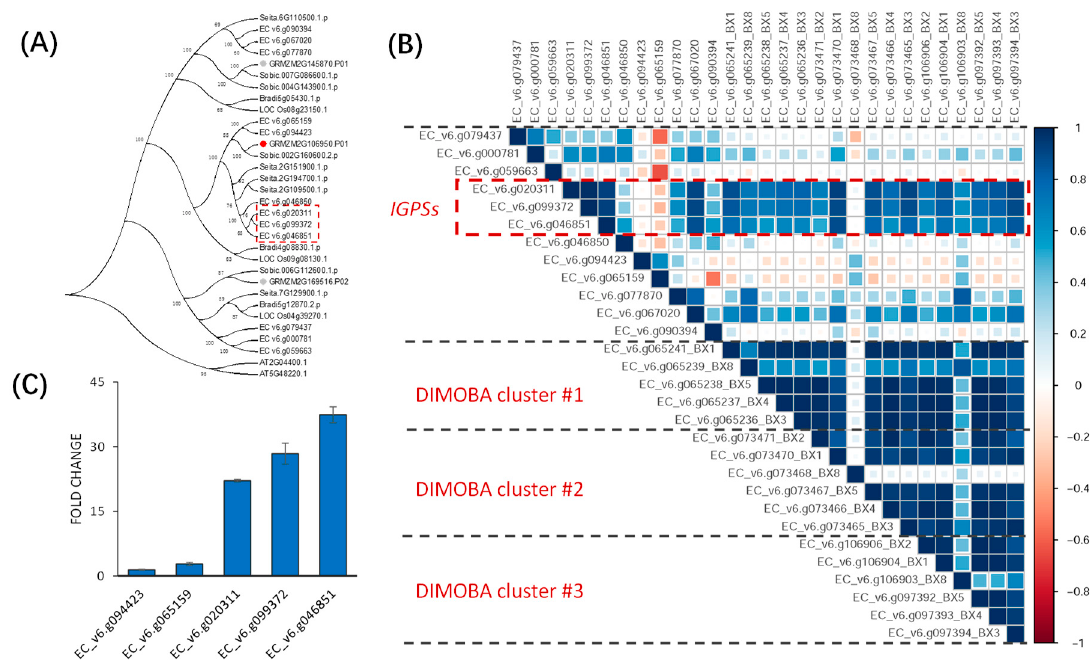
Figure 5. Co-expression pattern between genes in three copies of the DIMBOA cluster and IGPS orthologs in barnyardgrass. ( A ) Phylogenetic tree for genes homologous to IGPS across 6 grass species and Arabidopsis thaliana . The gene encoding indole-3-glycerolphosphate synthase ( IGPS ) in maize is highlighted in the red dotand the two homologous genes in maize are indicated by grey dots. Barnyardgrass orthologs are boxed in red dot box. ( B ) The co-expression coefficient matrix for genes in the three copies of the DIMBOA cluster and IGPS s in barnyardgrass. ( C ) Gene expression changes of the 5 barnyardgrass IGPS s after co-culturing with rice. Expression value of genes without co- culturing with rice was normalized to be one. Three biological replicates were used in the experiment.